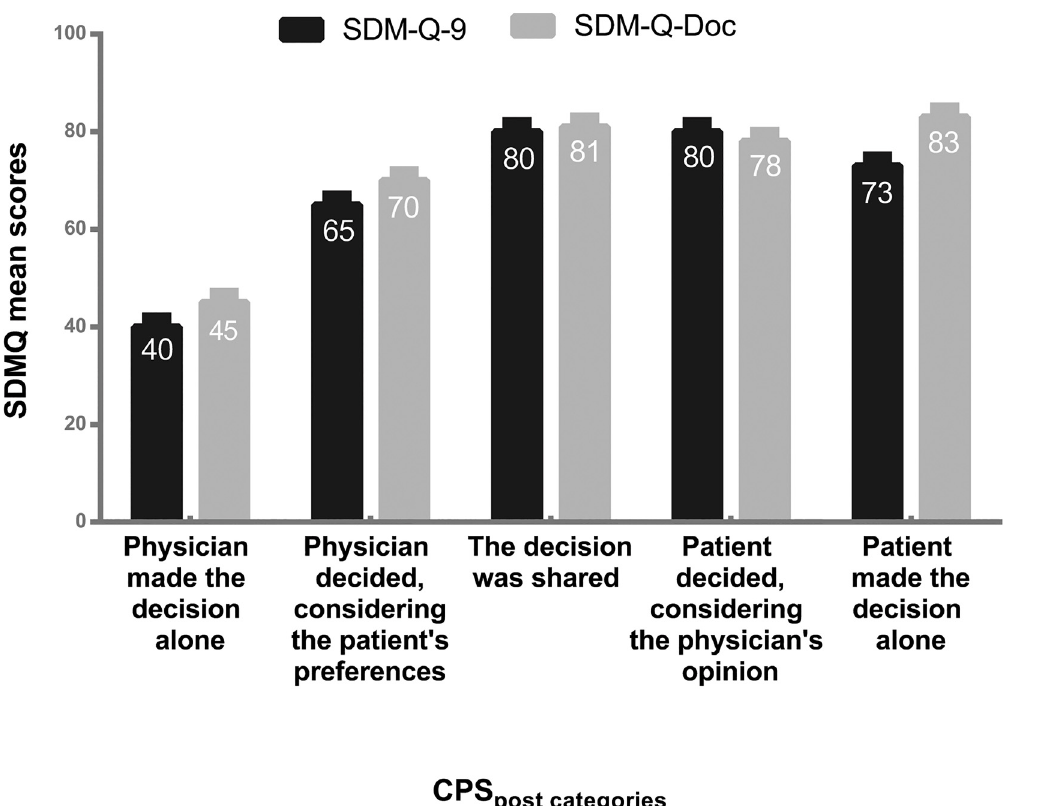
Fig 1. Mean SDM-Q-9 and SDM-Q-Doc scores by category of the CPS post. doi:10.1371/journal.pone.0132158.g001 were significant differences in total scores of both the SDM-Q-9 and the SDM-Q-Doc between the CPS categories (Table 4). Overlapping intervals indicate non-significant differences post categories. Table 5 shows the total SDM-Q-9/SDM-Q-Doc between the means of the CPS post item scale scores as well as the confidence intervals for the five categories of the CPS post (Table 5). As can directly be seen from the confidence intervals, all multiple comparison tests (both equal and unequal variances) indicated homogeneous subsets for the SDM-Q-9: (1,2,5) and (2,3,4,5) and for the SDM-Q-Doc (1), (2,4) and (3,4,5). Thus, as expected, category 1 ( “ Physician decided ” ) had a significantly lower mean SDM-Q- 9 score than categories 3 and 4 in the patient sample. The mean of category 2 ( “ Physician Table 4. Significance tests for the SDM-Q-9 and the SDM-Q-Doc using CPS post categories.